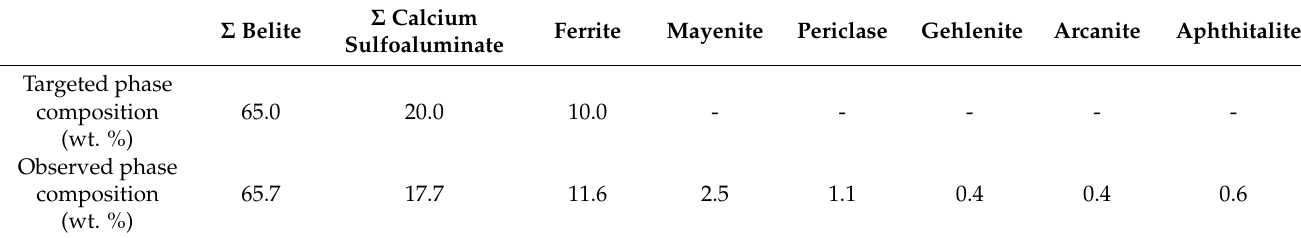
Table 1. Calculated targeted and observed phase composition of the synthesized cement clinker as obtained by Rietveld refinement in wt.